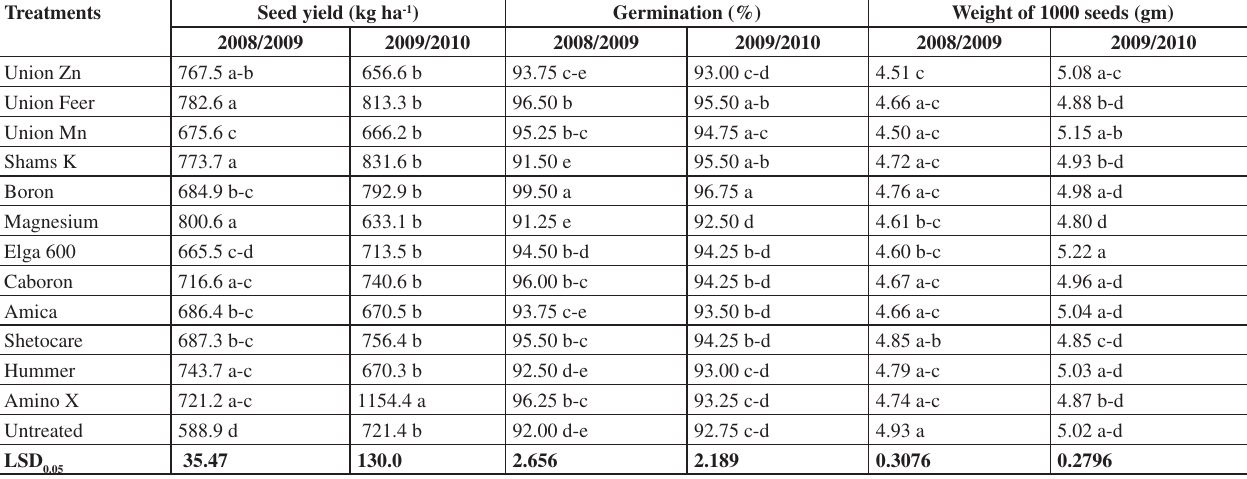
Table 4: Effect of foliar application with commercial compounds on seed yield per hectare, germination percent and weight of 1000 seeds (gm) in seasons of